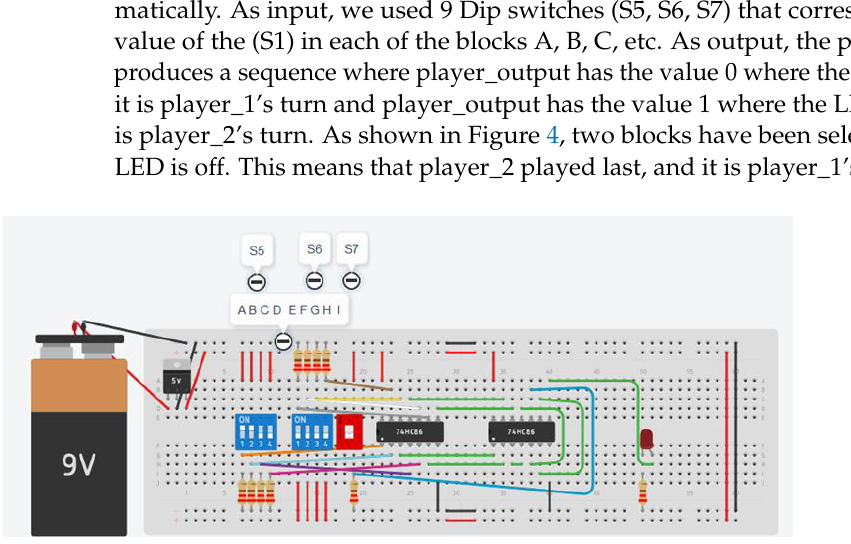
Figure 4. Player circuit